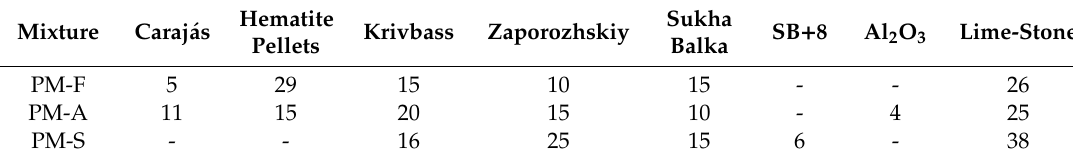
Table 2. Powder mixing ratio, wt.%. PM-F: an iron-rich mixture; PM-A: a high-alumina mixture (PM-A); PM-S: a high-silica mixture.